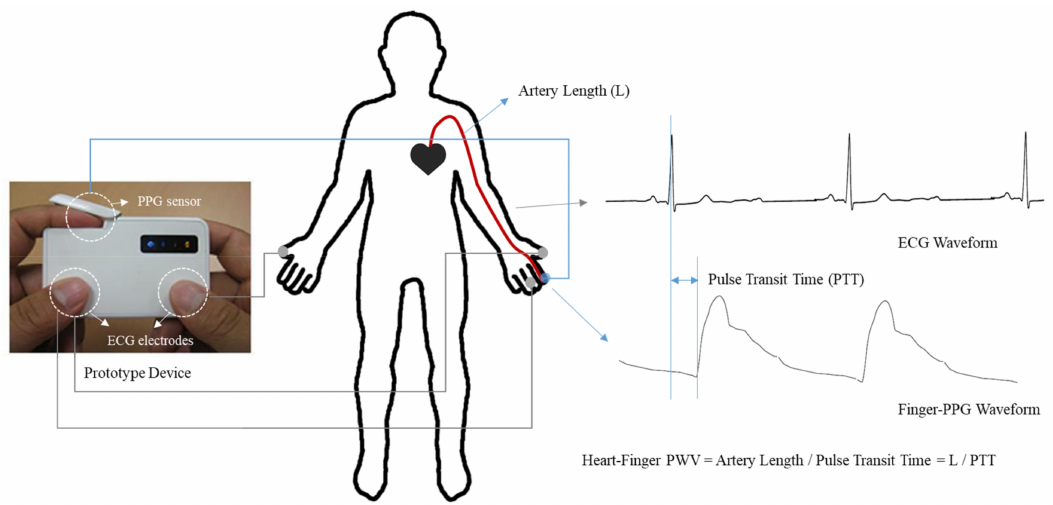
Figure 3. Measurements of heart–finger PWV with a prototype device equipped with contact-type ECG electrodes and a transmissive type PPG sensor.